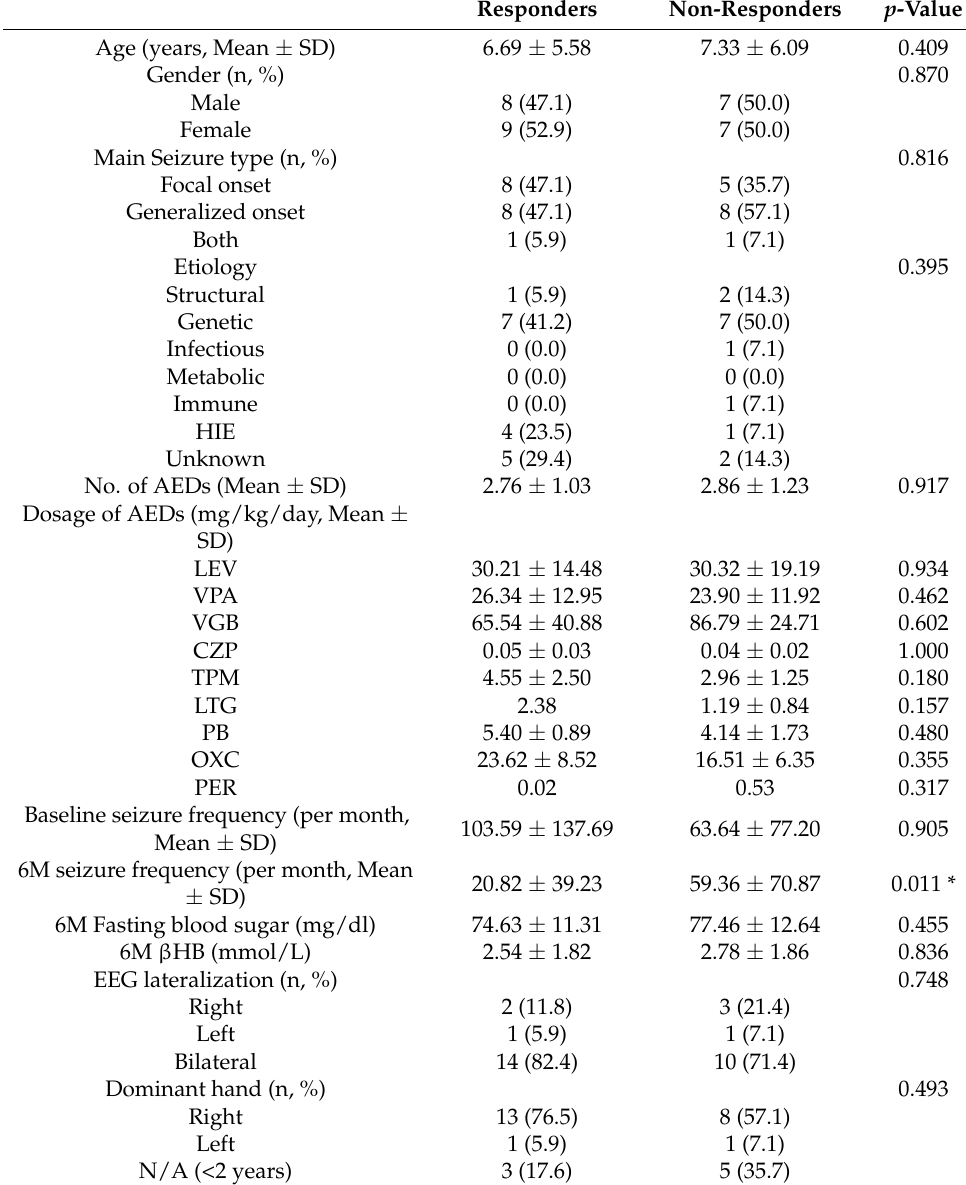
Table 1. Patient Demographics. Statistical comparison of clinical data between responders and non-responders. The 6M seizure frequency means the average frequency during the first 6 months of ketogenic diet therapy. Responders were those who achieved a seizure reduction rate of 50% or more, showing a significantly lower 6M seizure frequency compared to baseline. No statistical difference was identified between the two groups in the baseline condition, in the biochemical indicators during ketogenic diet therapy, or in brain lateralization. The dominant hand is not applicable in subjects younger than 2 years